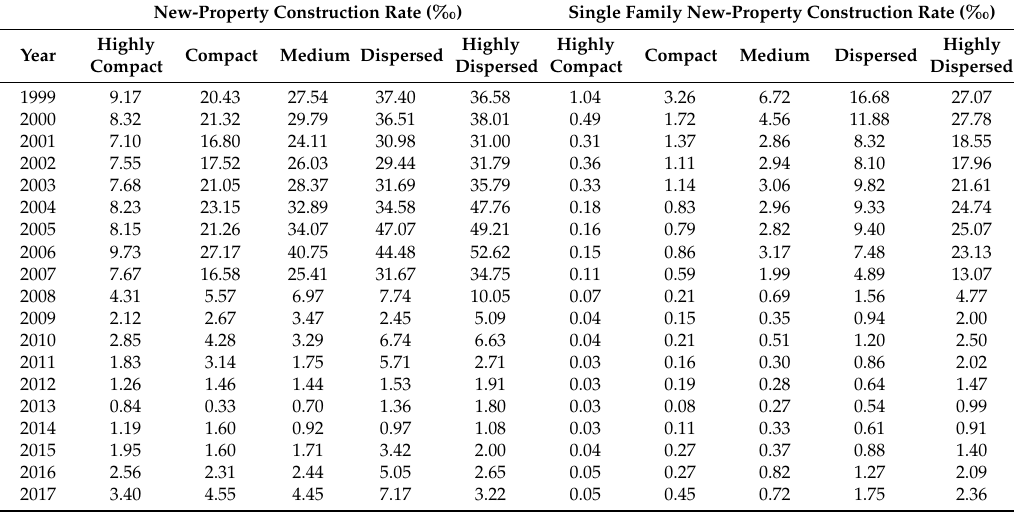
Table 3. New-property construction rate by types of municipality in the BMR, 1999–2017. New-Property Construction Rate (‰)